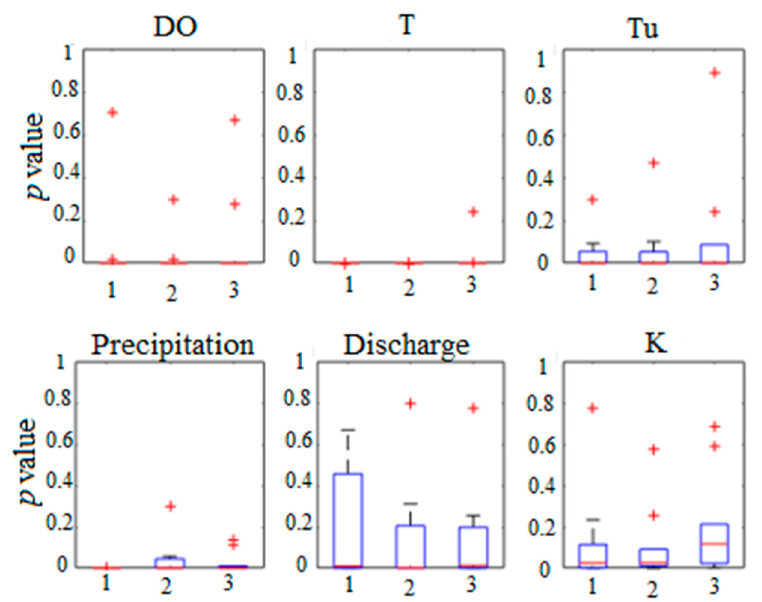
Figure 7. Box plots of p-values resulting from the Granger causality test when WT is Granger caused by DO, T, Tu, precipitation, discharge, and K based on a lag time of 1, 2, and 3 days and performed for each watershed. The 25th and 75th percentiles are shown by the blue boxes, while the central red line shows the median. Whiskers extended to minimum and maximum do not consider the outliers, shown with red crosses.